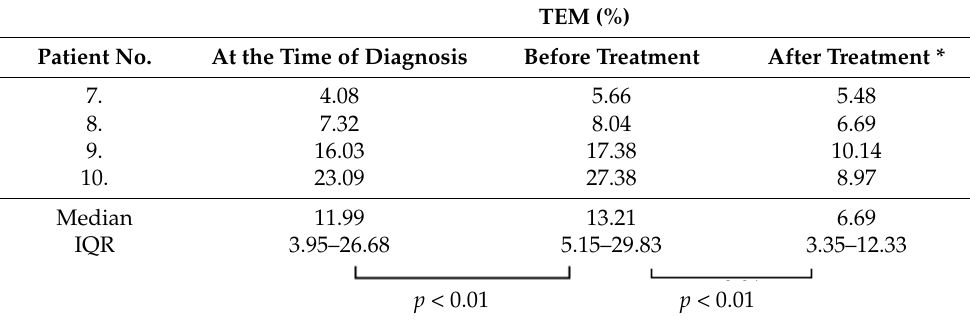
Table 2. TEM percentage in CLL patients over time. Each row in a table represents a set of related data for an individual patient. Patient No.